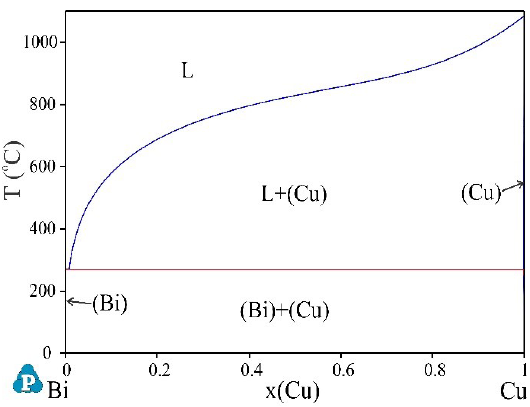
Figure 1. Bi-Cu phase diagram calculated using thermodynamic data established By Teppo et al. 13 .